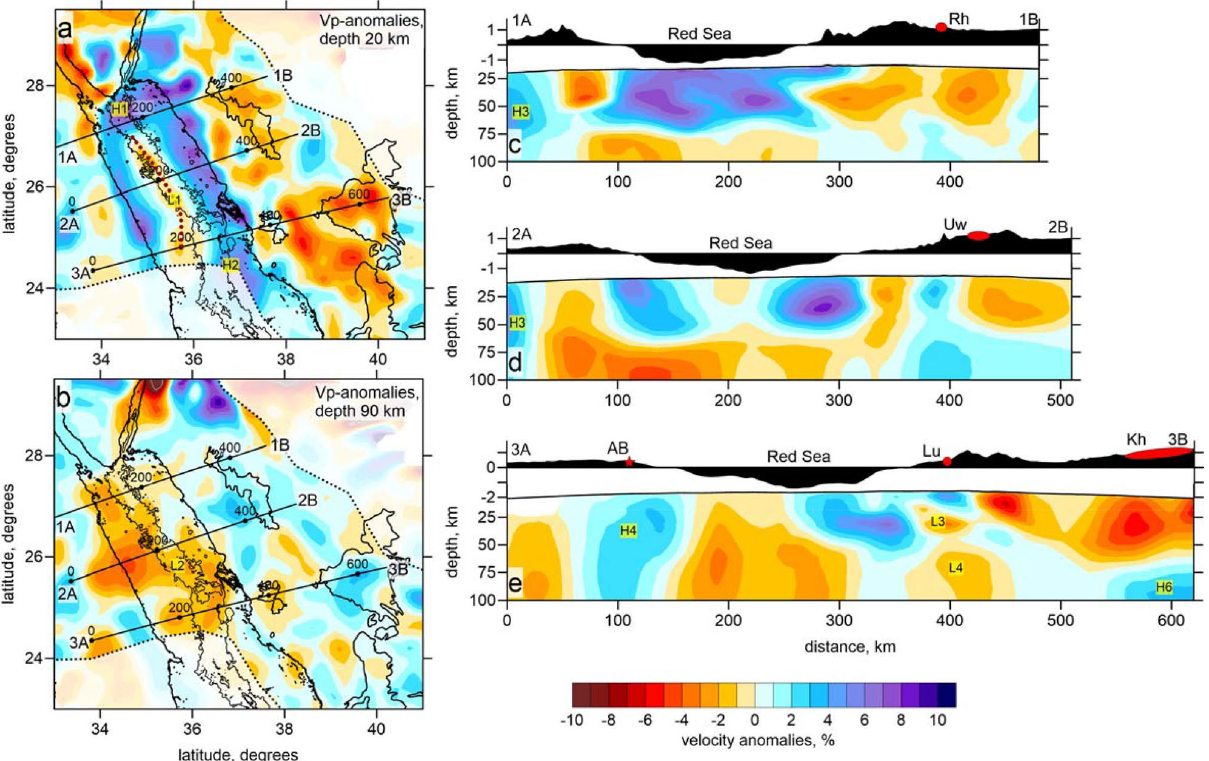
Figure 2. P -wave velocity anomalies obtained from tomographic inversion presented in two horizontal (panels a , b ) and three vertical (panels c – e ) sections. In the maps, the contours of harrats are shown on the Saudi Arabian side. Within the Red Sea, the bathymetry is shown with contour lines starting from 1000 m and at an interval of 500 m. Above each of the vertical sections, the topography/bathymetry along the profile is shown. The locations of the main harrats are shown in red ellipses as follows: Rh – ar Rahah, Uw – Uwayrid, Lu – Lunayyir, Kh – Khaybar, and Rt – Rahat. AB is Abu-Dabbab. Dotted lines indicate political boundaries. Letters in yellow indicate the structures discussed in the text. The images have been produced using the Surfer Golden Software 13 (https:// www. golde nsoft ware. com/ produ cts/